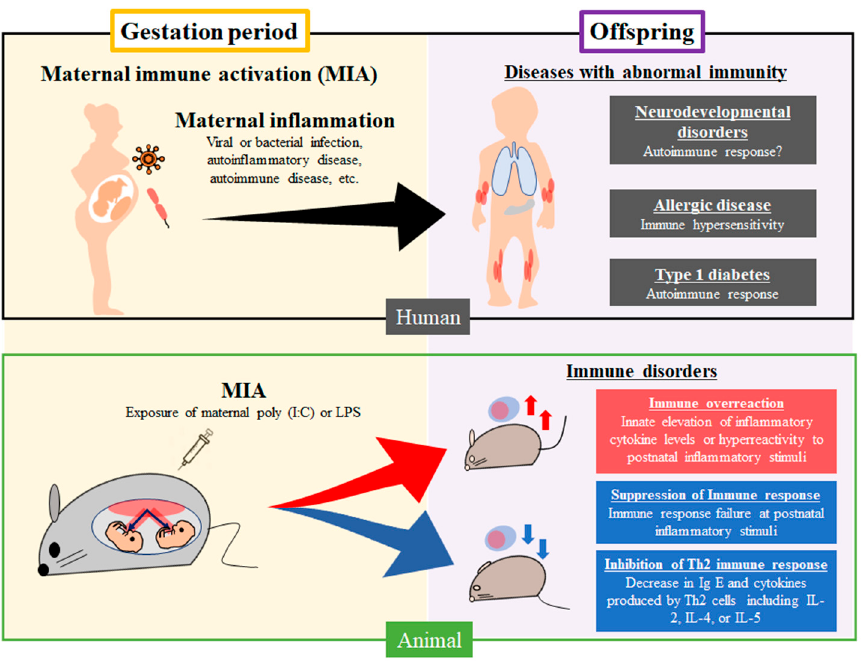
Figure 2. Epidemiologic and experimental data associated with MIA and immune disorders in human and animal models.